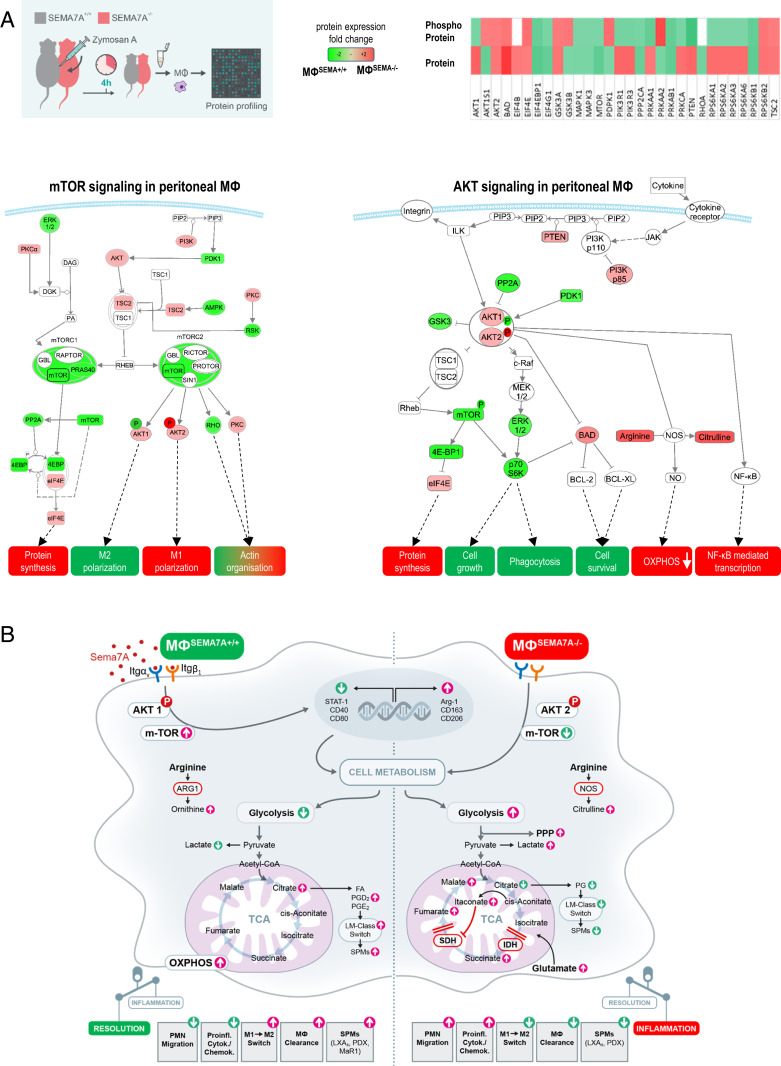
Sema7A-dependent macrophage intracellular signaling. SEMA7A+/+ and SEMA7A−/− animals were injected intraperitoneally with ZyA, and peritoneal MΦs were collected 4 h later. (A) The mTOR- and AKT-signaling pathways were assessed by protein expression and phosphorylation analysis by using a protein microarray. Samples were pooled from three to four mice in each group for each experiment. (B) Schematic model of the cellular effects of Sema7A.